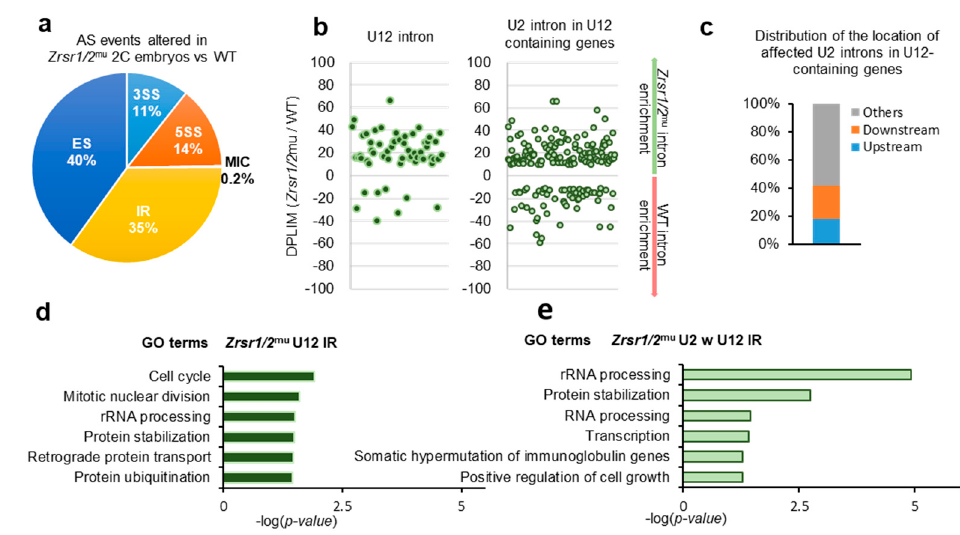
Figure 2. RNA-seq analysis of alternative splicing (AS) events in Zrsr1/2 mu 2-cell (2C) embryos. ( a ) Distributions of categories of AS events differing in Zrsr1/2 mu embryos versus WT. The percentage of each class of events is indicated. Note: 3SS, alternative 3 ′ splice sites; 5SS, alternative 5 ′ splice sites; ES, exon skipping; MIC, alternative micro cassette exon ≤ 15 nucleotides; IR, intron retention. ( b ) Differences in intron retention events detected in Zrsr1/2 mu compared to WT embryos (measured as the ratio of intron read counts (DPLIM) in Zrsr1/2 mu versus WT) for different intron categories, as indicated. ( c ) Distributions of the locations of a ff ected U2 introns in Zrsr1 / 2 mu embryos relative to U12 introns present in the same gene. ( d ) Significant GO terms for U12-type introns represented in graph “B” to the left. ( e ) Significant GO terms for U2 introns within (w) U12-containing genes represented in graph “B” to the